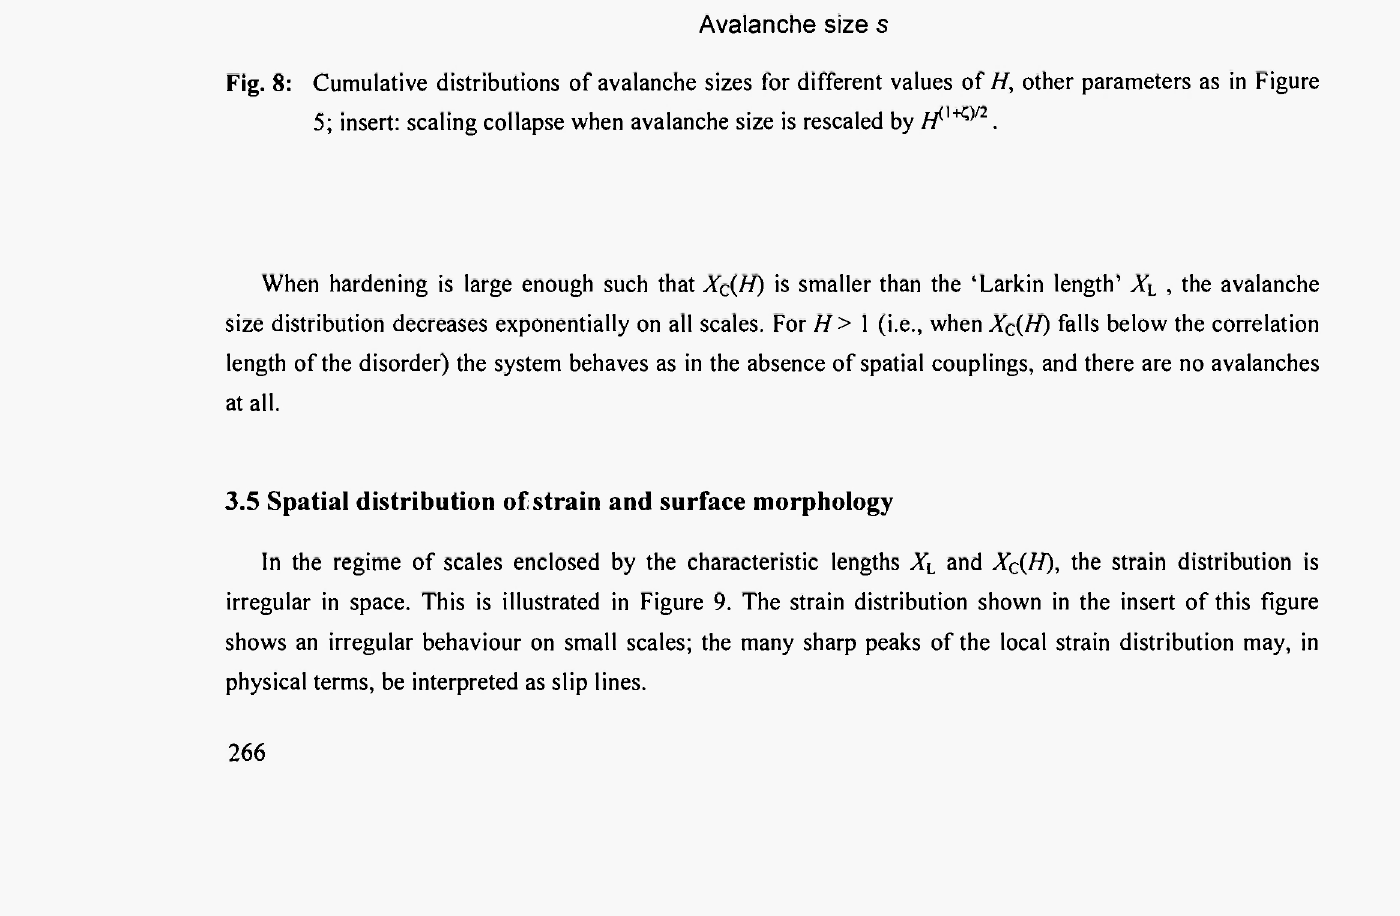
Fig. 8: Cumulative distributions of avalanche sizes for different values of H, other parameters as in Figure 5; insert: scaling collapse when avalanche size is rescaled by H (]<) ' 2